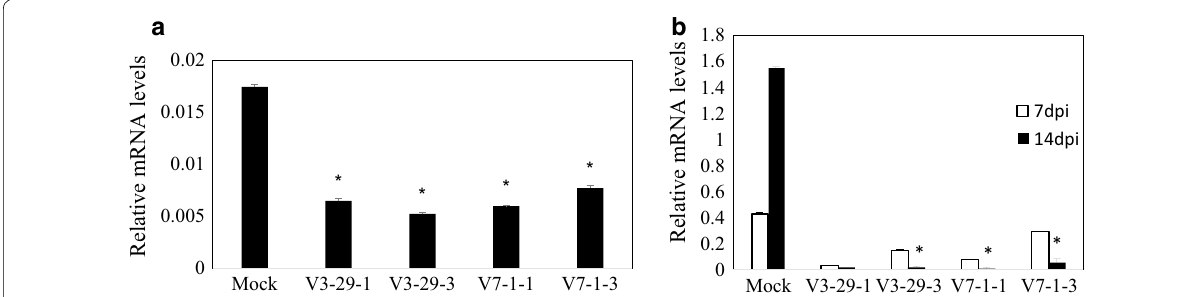
Fig. 6 Molecular detection of T 2 plants. a GmVma12 expression level in T 2 RNAi silenced transgenic plants by qRT-PCR. b SMV accumulation in SMV-infected T 2 transgenic plants by qRT-PCR. Y-axes indicate the transcript levels of GmVma12 (7 dpi) and SMV (7 dpi and 14dpi) of SMV-infected plants. X-axes indicate T 2 transgenic plants and non-transformed (Mock) plants. Data are expressed as the means of three biological replicates with error bars indicating the SD (n 3). Asterisks denote significant difference from mock, as determined by the t -test, p < 0.001. Each result is = representative of three biological repeats